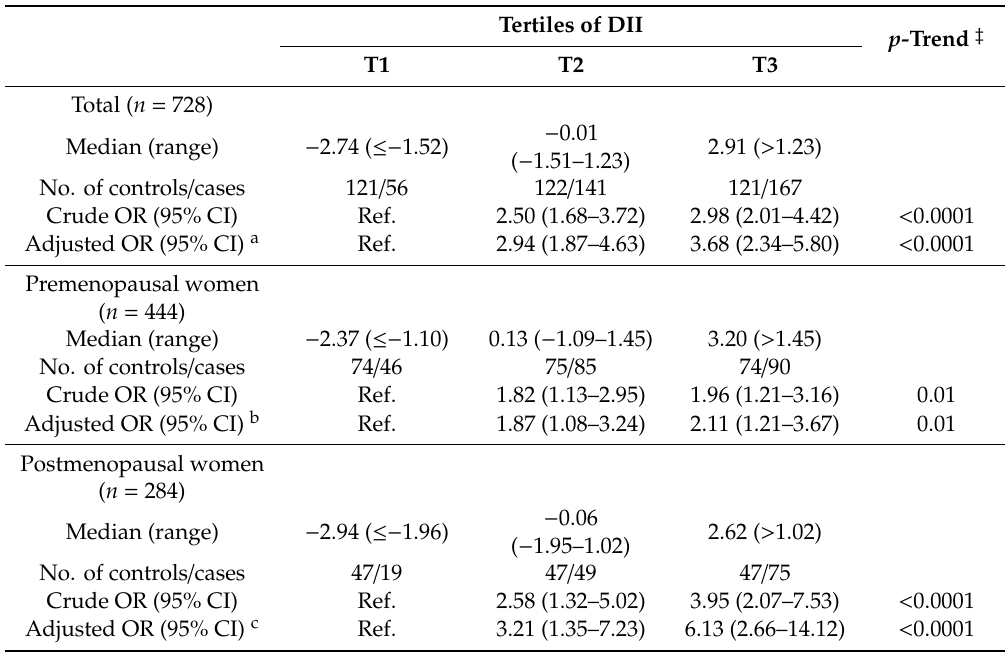
Table 3. Odds ratios (95% CIs) of breast cancer and Dietary Inflammatory Index (DII)